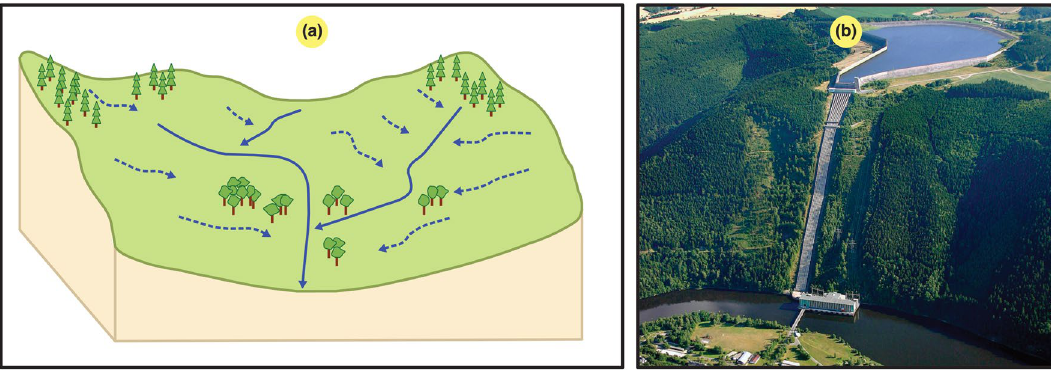
Figure 6. Illustration of the surface areas needed for hydroelectric power generation. ( a ) Catchment area (i.e., source area, A s ) used to collect the water. ( b ) Reservoir-allocated surface area ( A g ) of the Hohenwarte II pumped-storage power plant (taken by Vattenfall on October 19, 2011, https:// www. flickr. com/ photos/ vatte nfall/ 67794 52824, published under the courtesy of the CC BY-NC-ND 2.0 license, https:// creat iveco mmons. org/ licen ses/ by- nc- nd/2.